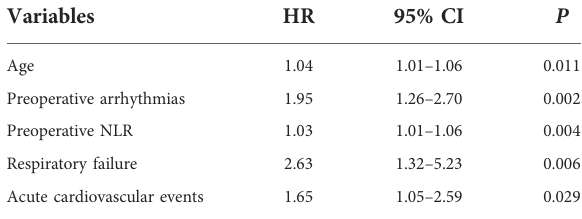
TABLE 3 Predictive factors for 1-year mortality among hip fracture patients: multivariate analysis.